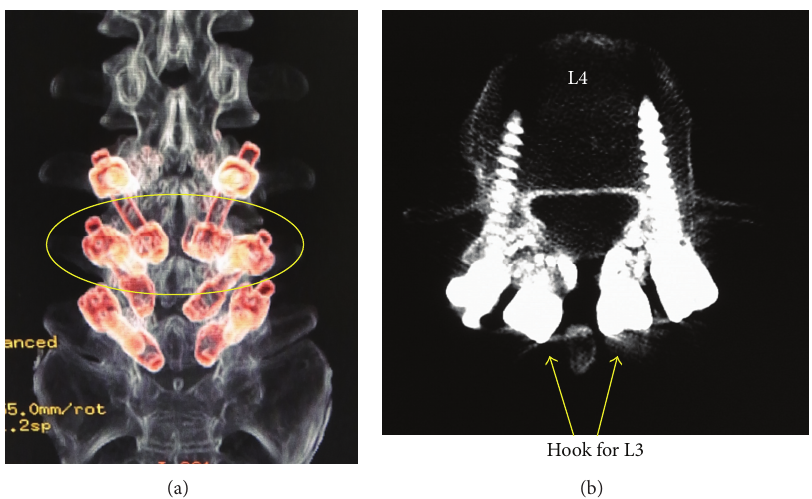
Figure 6: CT after the surgery. Note the proximity of the hook head to L3 and the pedicle screw head to L4.